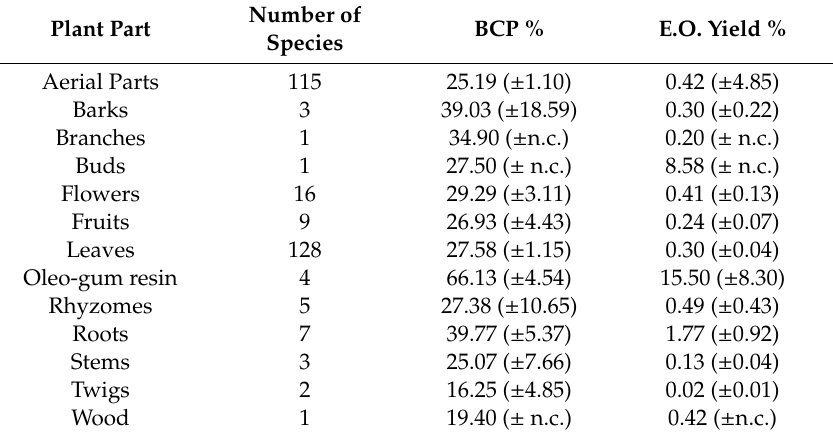
Table 3. Average percentages of BCP and yields from plant parts as reported in plant species listed in Table 1. ( ± S.E.M.); n.c., not computable; E.O., essential